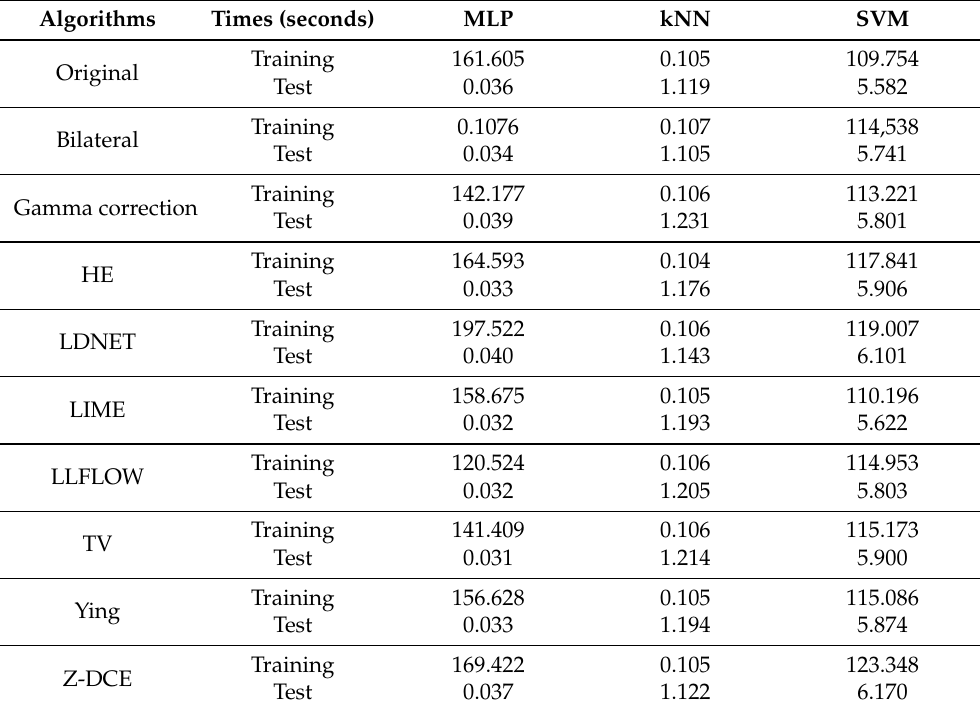
Table 4. Training and testing times of image enhancement algorithms and the classifiers.